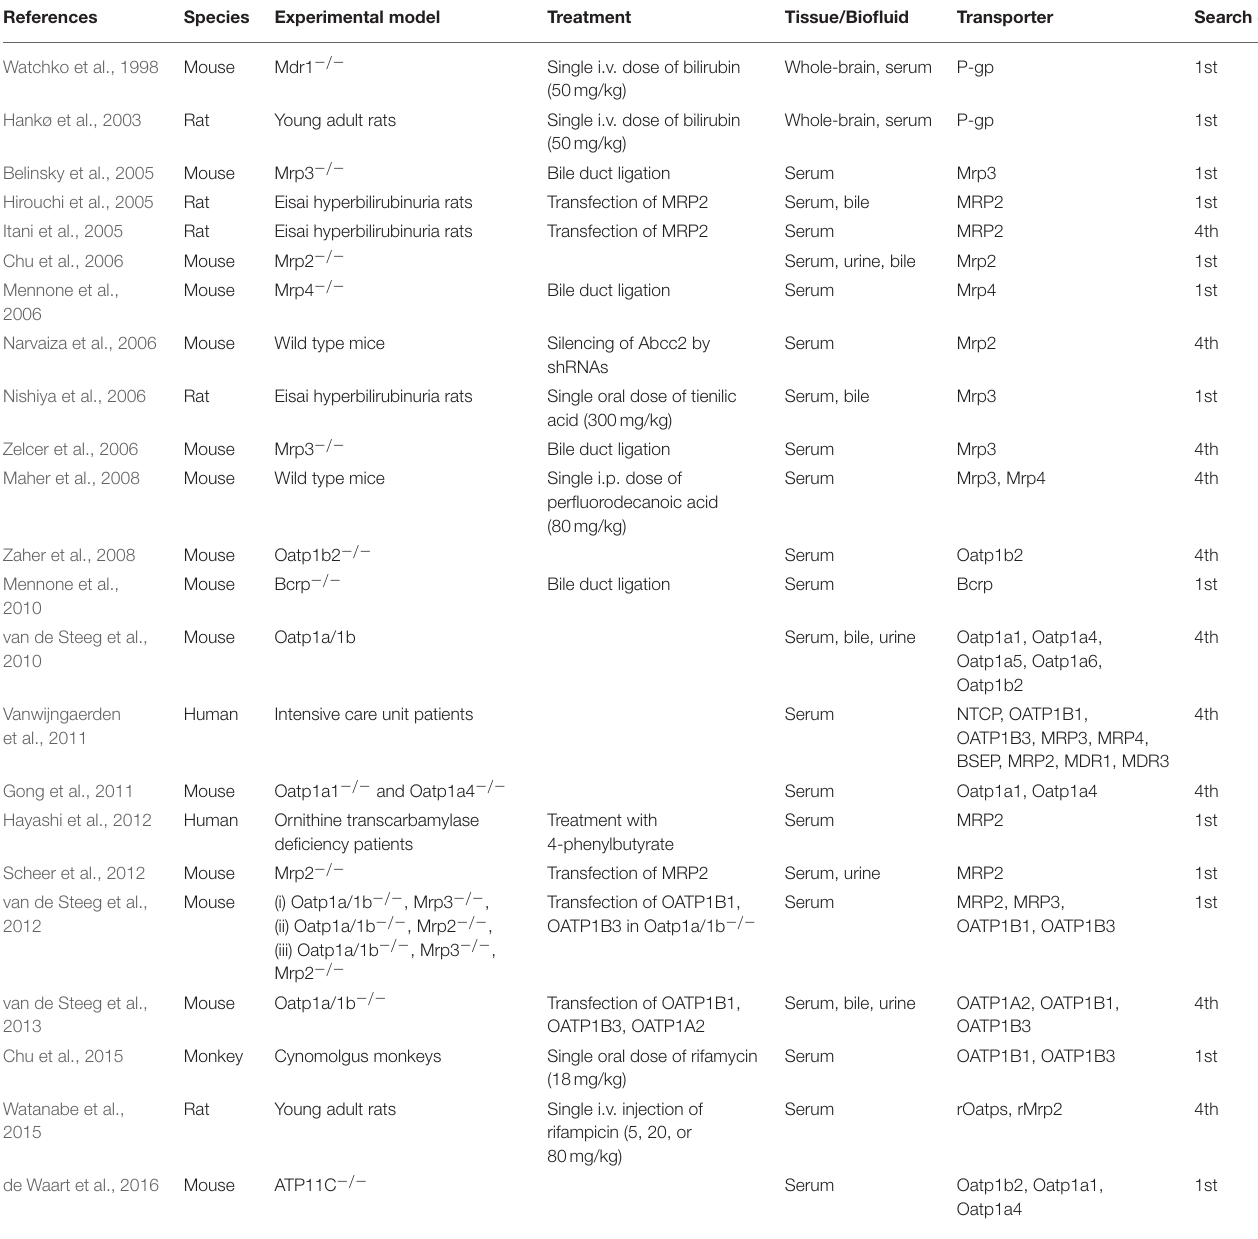
TABLE 4 | Features of included articles reporting in vivo